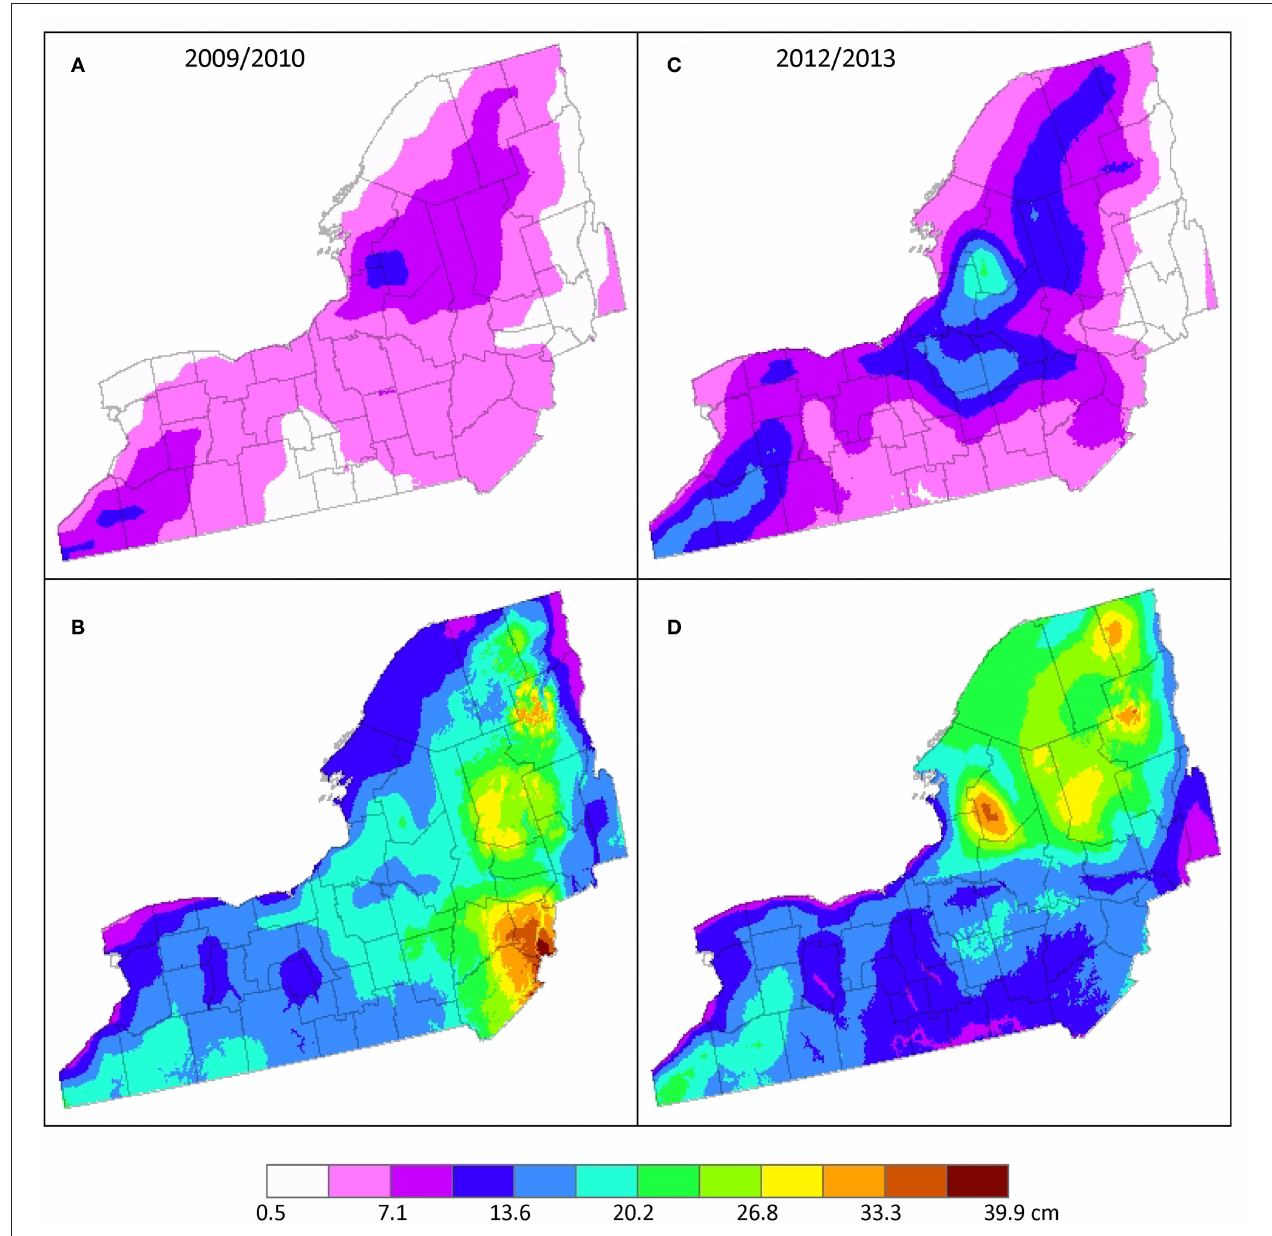
FIGURE 5 | The 2009/2010 cold-season LWE snowfall (cm) for (A) LES days and (B) non-LES days and the 2012/2013 cold-season LWE snowfall for (C) LES days and (D) non-LES days in the vicinity of Lake Ontario.